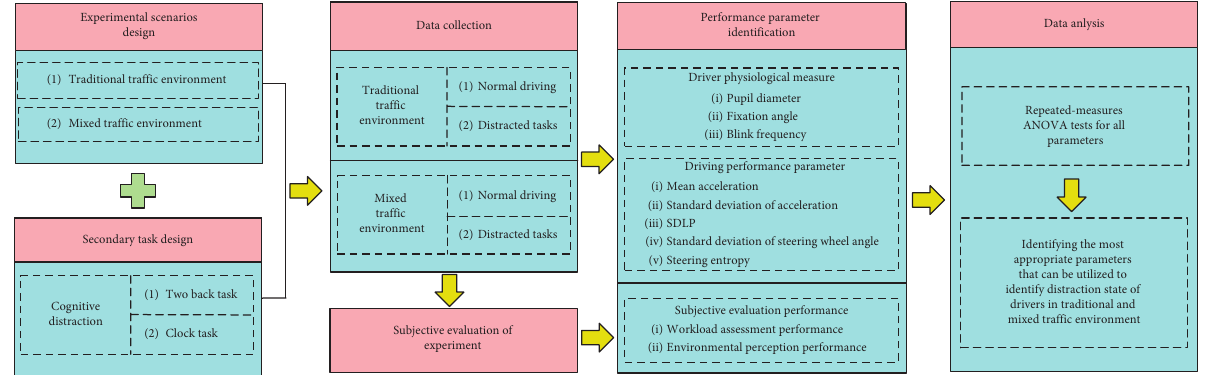
Figure 1: Framework of the methodology adopted for this